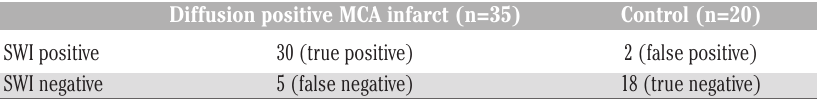
Table 2. Sensitivity and specificity of susceptibility-weighted images for intra-arterial clot.